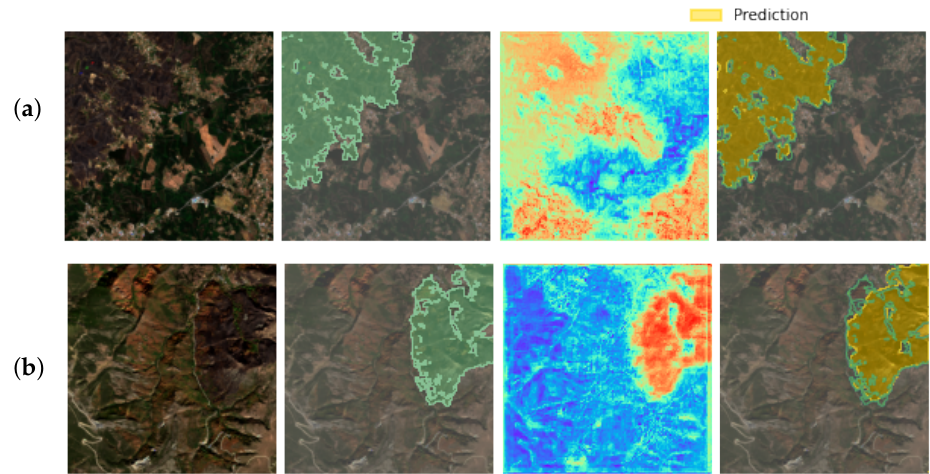
Figure 5. Visualization of the last binary attention level compared to the network prediction. The first column is the RGB visualization of the input, the second is the binary ground truth, the third is the attention map (the intensity scale goes from blue to red for lower to higher attention values, respectively), while the last is the prediction. Rows ( a ) and ( b ) are two satellite examples from coral and cyan fold,